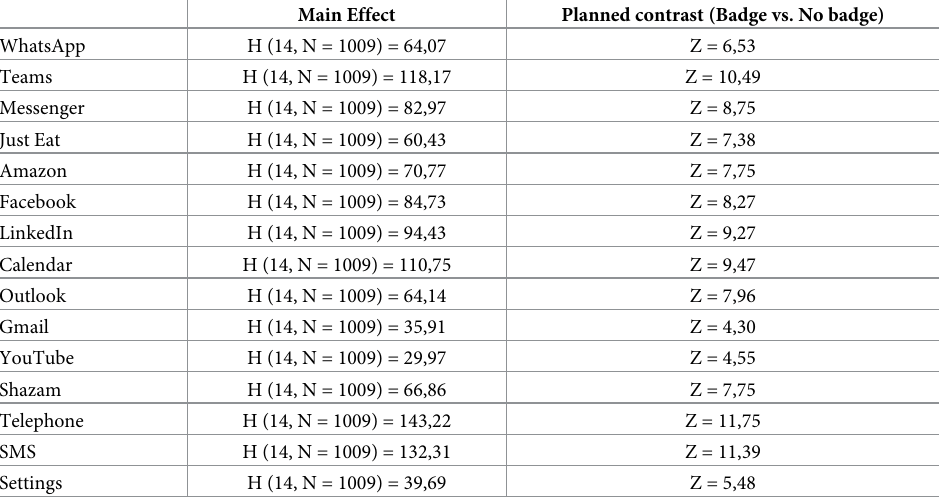
Table 2. Main effects and planned contrasts for each of the apps. Main effects were calculated using the Kruskal– Wallis H test (all ps < .001). Planned contrasts were calculated with the adjusted Mann–Whitney U test (all ps < .001).